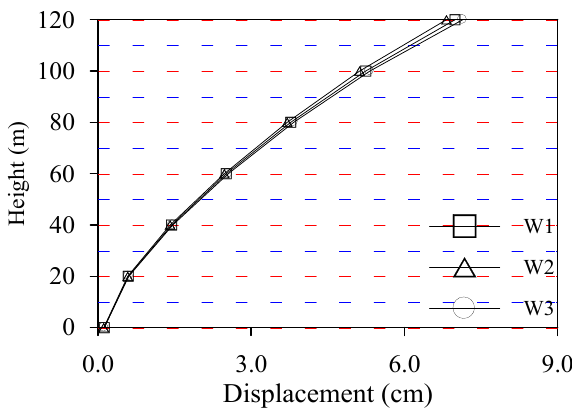
(b) Fig. 13. The maximum (a) and minimum (b) stresses at section I-I of arch dam for Case P. The time histories of maximum principal stresses (tensile stress) at nodal point 48, which is